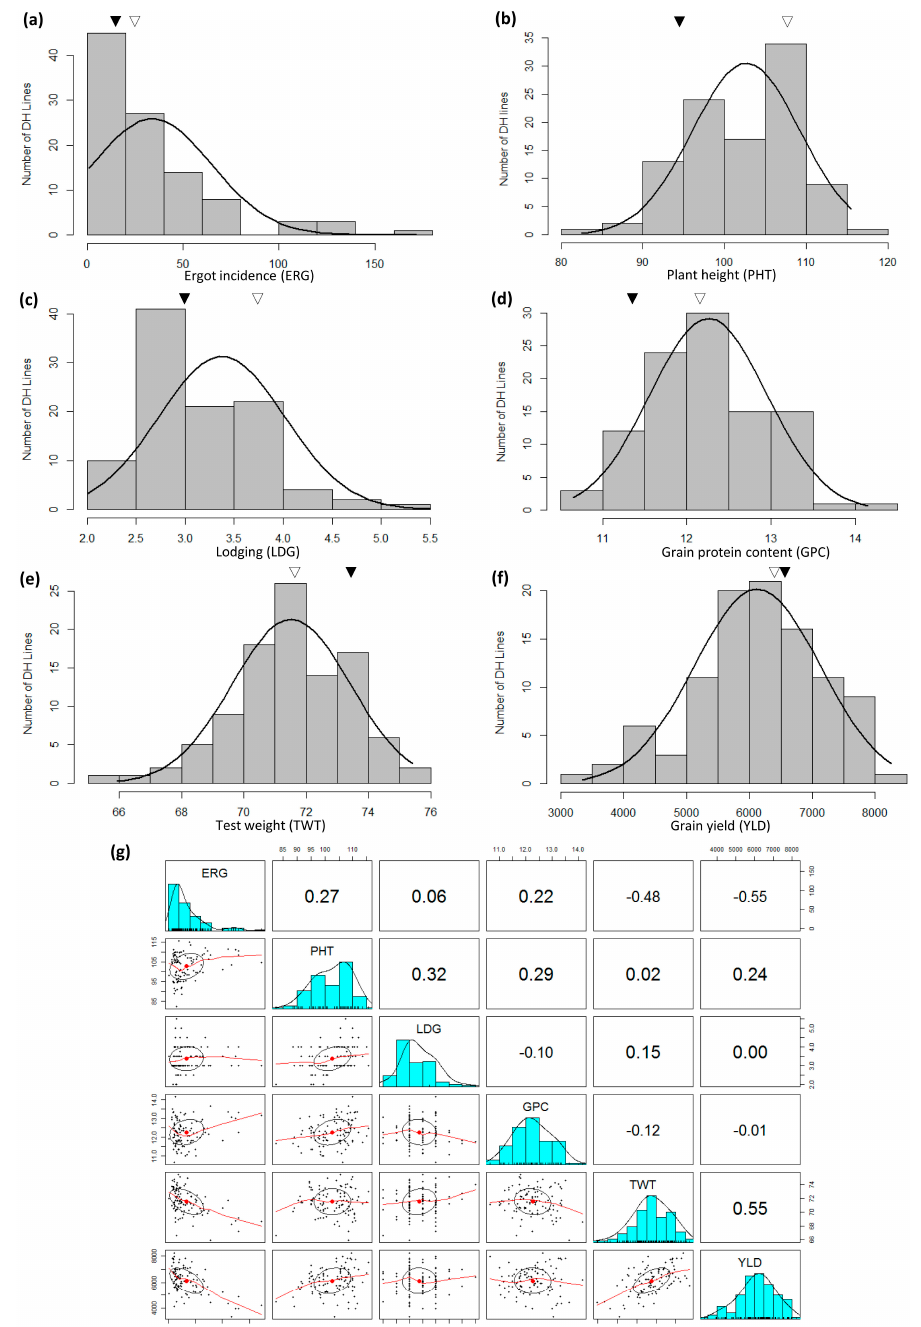
Figure 3. Frequency distribution of 100 doubled haploid lines of triticale genetic mapping population produced from a biparental cross between TMP16315 and AC Ultima for mean of six traits namely: ( a ) ergot incidence (ERG, pieces/L), ( b ) plant height (PHT, cm), ( c ) lodging (LDG, 1–9 scale), ( d ) grain protein content (GPC, %), ( e ) test weight (TWT, kg/hL) and ( f ) grain yield (YLD, kg/ha) evaluated at Lethbridge. The means of the parental genotypes are indicated over graphs by triangles (AC Ultima, hollow triangle; TMP16316, solid triangle). ( g ) Scatterplot of above six traits (ERG, PHT, LDG, GPC, TWT and YLD) evaluated at Lethbridge. Correlation coefficients (top diagonals) and regression line (lower diagonals) deciphered relationship among different traits studied.